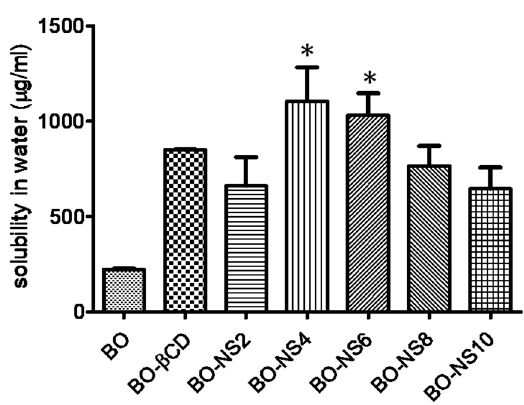
Figure 1. Solubilization of babchi oil (BO) by nanosponges (having different cross-linking density) and β -CD. Statistical data analysis from the one-way ANOVA (and nonparametric) Kruskal-Wallis test (solubilisation effeciency: Kruskal-Wallis statistics: 15.10) was followed by the Dunn’s multiple comparison test (* p < 0.05 versus BO).